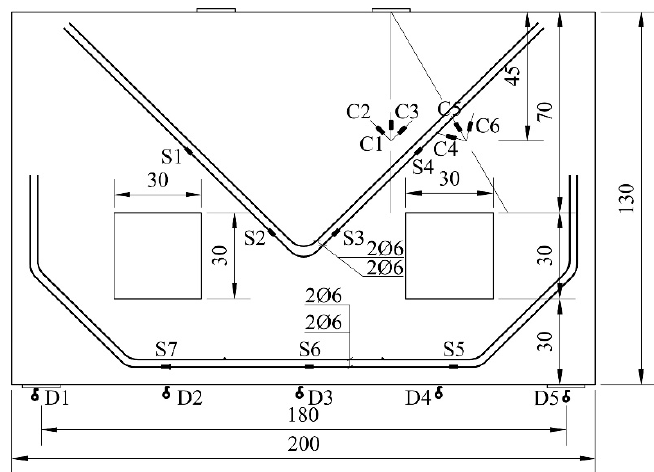
Figure 13. The arrangements of comparators for measuring deflection and strain gauges for specimen Figure13. ThearrangementsofcomparatorsformeasuringdeflectionandstraingaugesforspecimenW3. Appl. Sci. 2020 , 10 , x FOR PEER REVIEW W3.